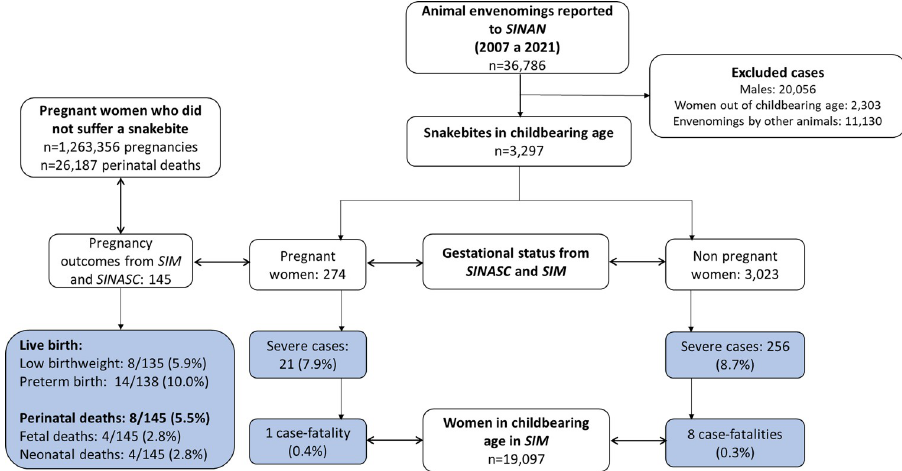
Fig 1. Study flowcharts, with absolute numbers and frequencies of snakebite envenomations in women of childbearing age and pregnant women, and maternal and perinatal outcomes. SINAN : Case Reporting Information System; SINASC : Live Birth Information System; SIM : Mortality Information